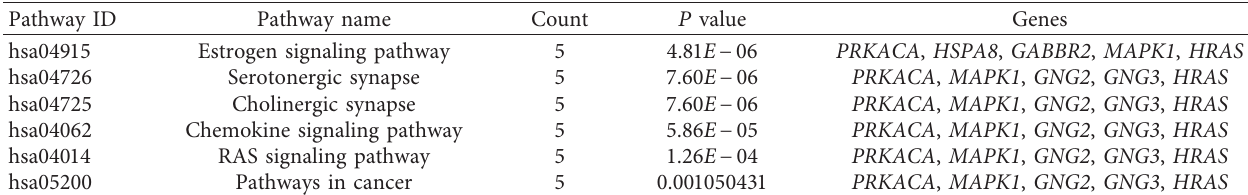
Figure 6: The top 10 hub genes in the PPI network. Blue represents downregulated genes, red represents upregulated genes, solid lines represent direct interactions between genes, and dotted lines represent indirect interactions between genes. Table 3: List of KEGG pathways of hub